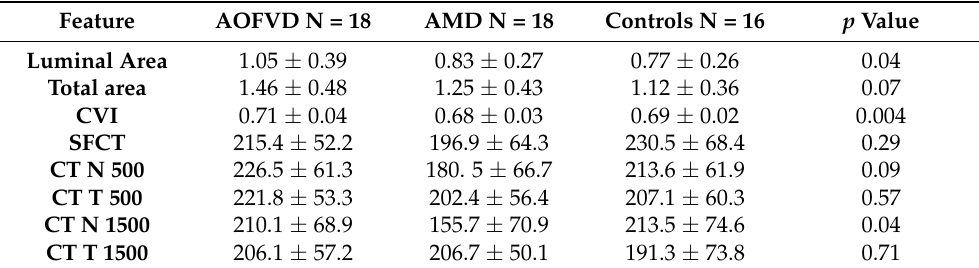
Table 2. Clinical features in adult-onset foveomacular vitelliform dystrophy (AOFVD) and age- related macular degeneration with conventional drusen.